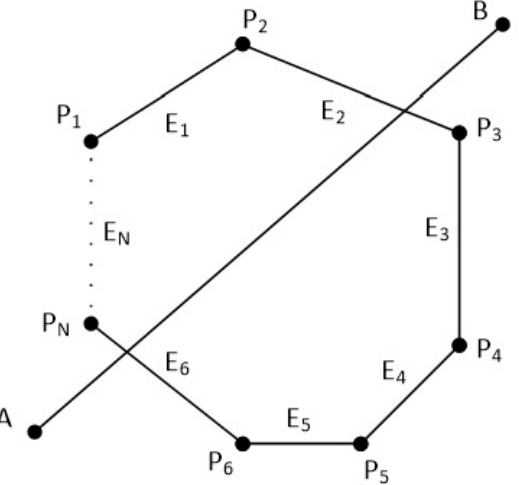
Figure 38. A convex polygon with N points and N edges and a line in the 2D